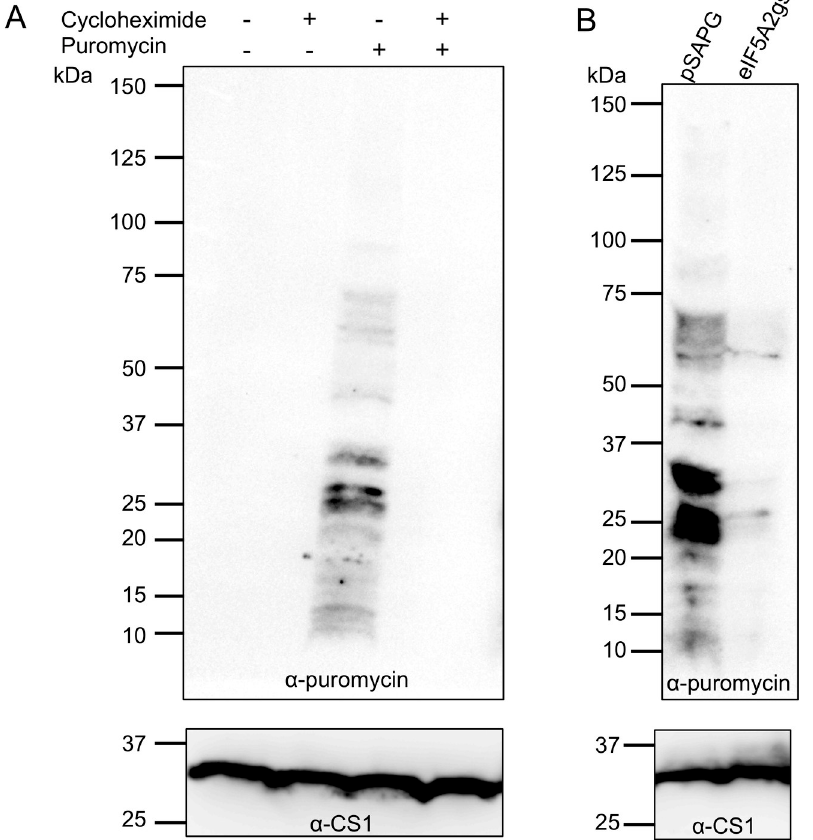
Fig 8. SUnSET analysis of active protein synthesis. (A) SUnSET analysis of wild type strain. Trophozoites of E . histolytica clonal strain HM-1:IMSS cl 6 were incubated in normal growth medium with 100 μ g/ml cycloheximide, 10 μ g/ml puromycin, or both. Cell lysates were subjected to SDS-PAGE and immunoblot using antibody specific for puromycin. Note that trophozoites incorporated puromycin into proteins (P). The incorporation was blocked by cycloheximide treatment (C + P). These data validated the SUnSET analysis for assessing protein synthesis in E . histolytica . (B) SUnSET analysis of EheIF5A2 gs strain. Trophozoites from EheIF5A2 gs and control (pSAP2G) strains were subjected to SUnSET analysis as in (A). Equal protein loads were confirmed with CS1 antibody (lower panels). Representative data for at least 3 separate trials are